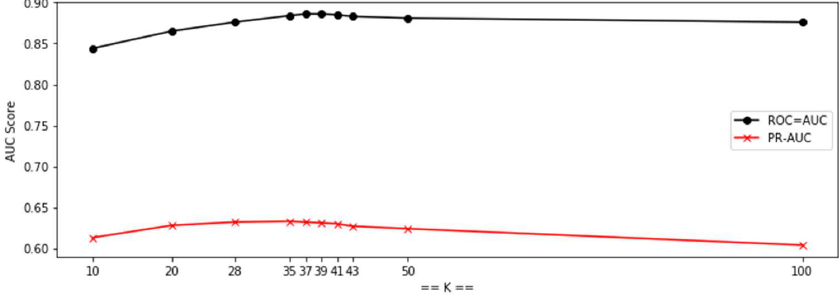
Figure 13. ROC and PR as a several results of k in